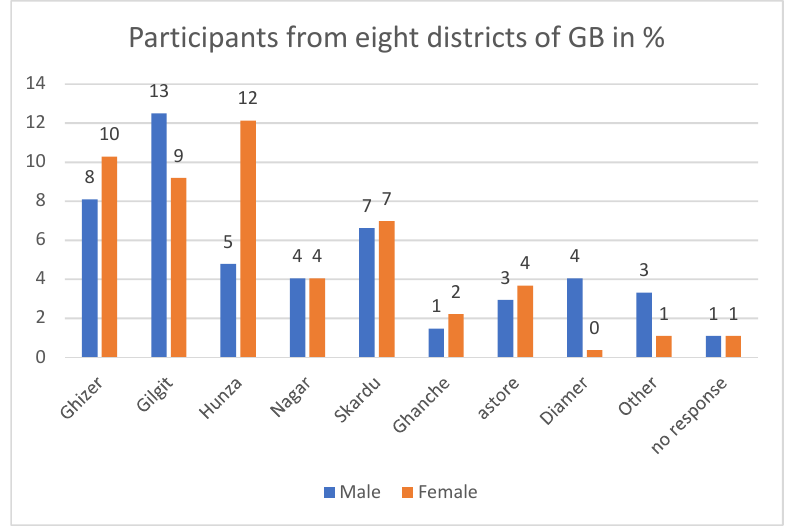
Figure 3. District-wise participants in percentage.